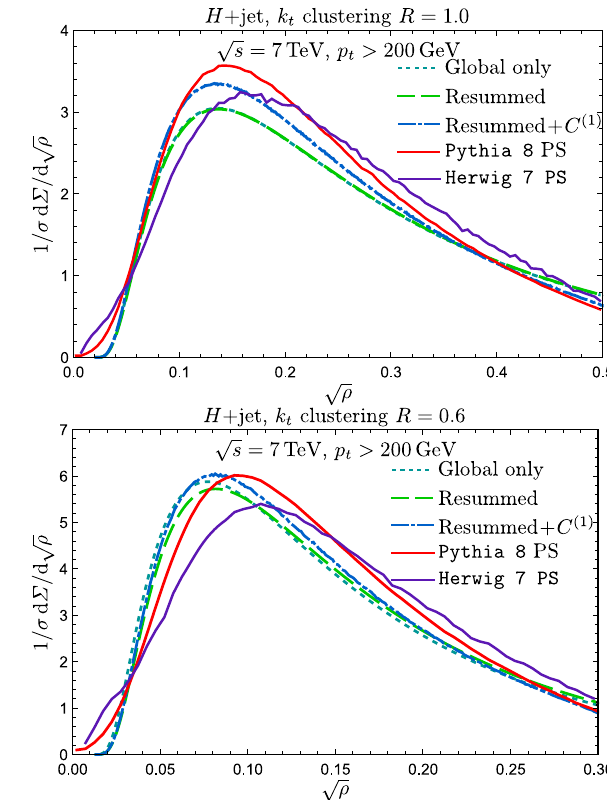
Fig. 9 Resummed differential jet mass distribution in Z + jet events with k t clustering compared to Pythia 8 and Herwig 7 PS